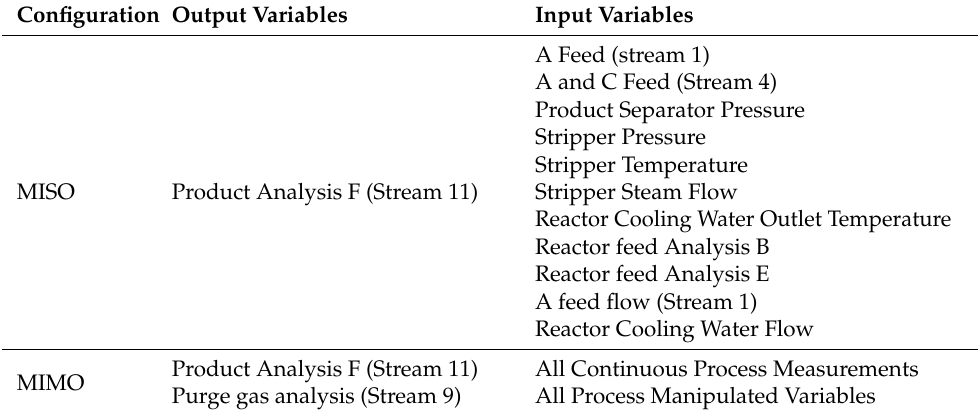
Table 1. The list of selected inputs and outputs for the MISO and MIMO configurations. A detailed description of the variables can be found in the original TEP paper